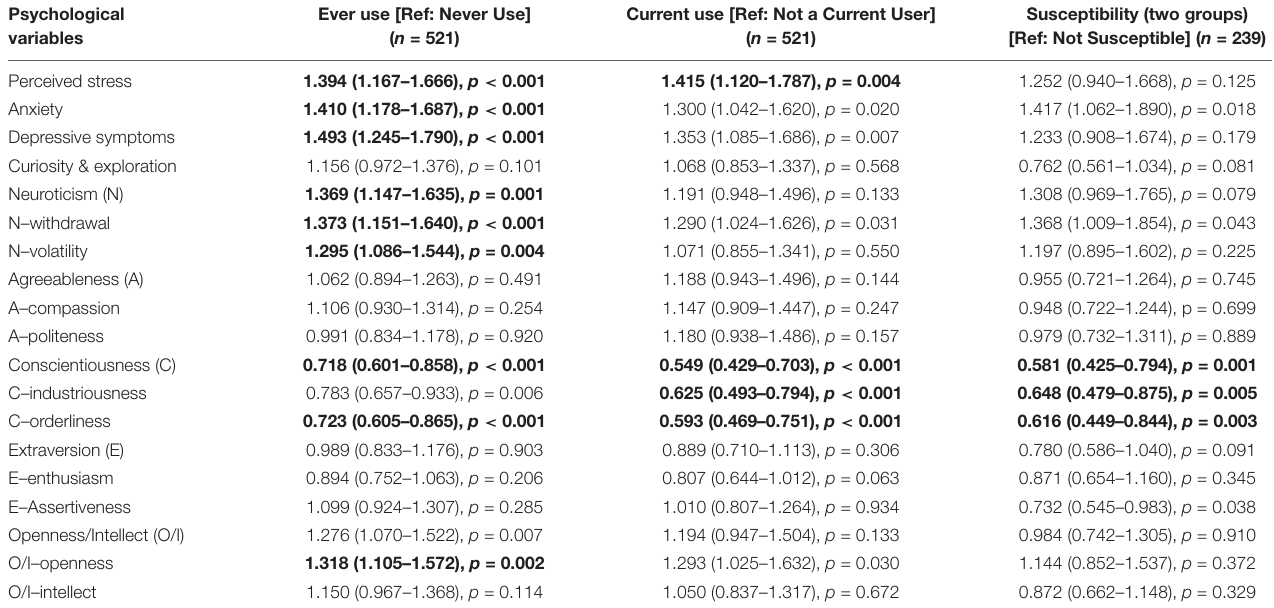
TABLE 3 | Results of independent logistic regressions showing estimates in odds ratios (confidence intervals) for psychological predictors of ENDS ever-use, current use, and susceptibility. Psychological Ever use [Ref: Never Use] variables ( n =